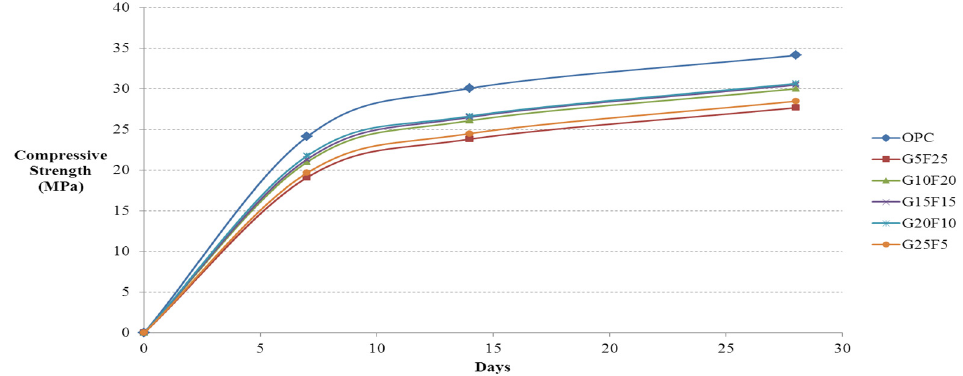
Figure 4. Compressive strength history of concrete with GGBS and flyash (W/B 50%).